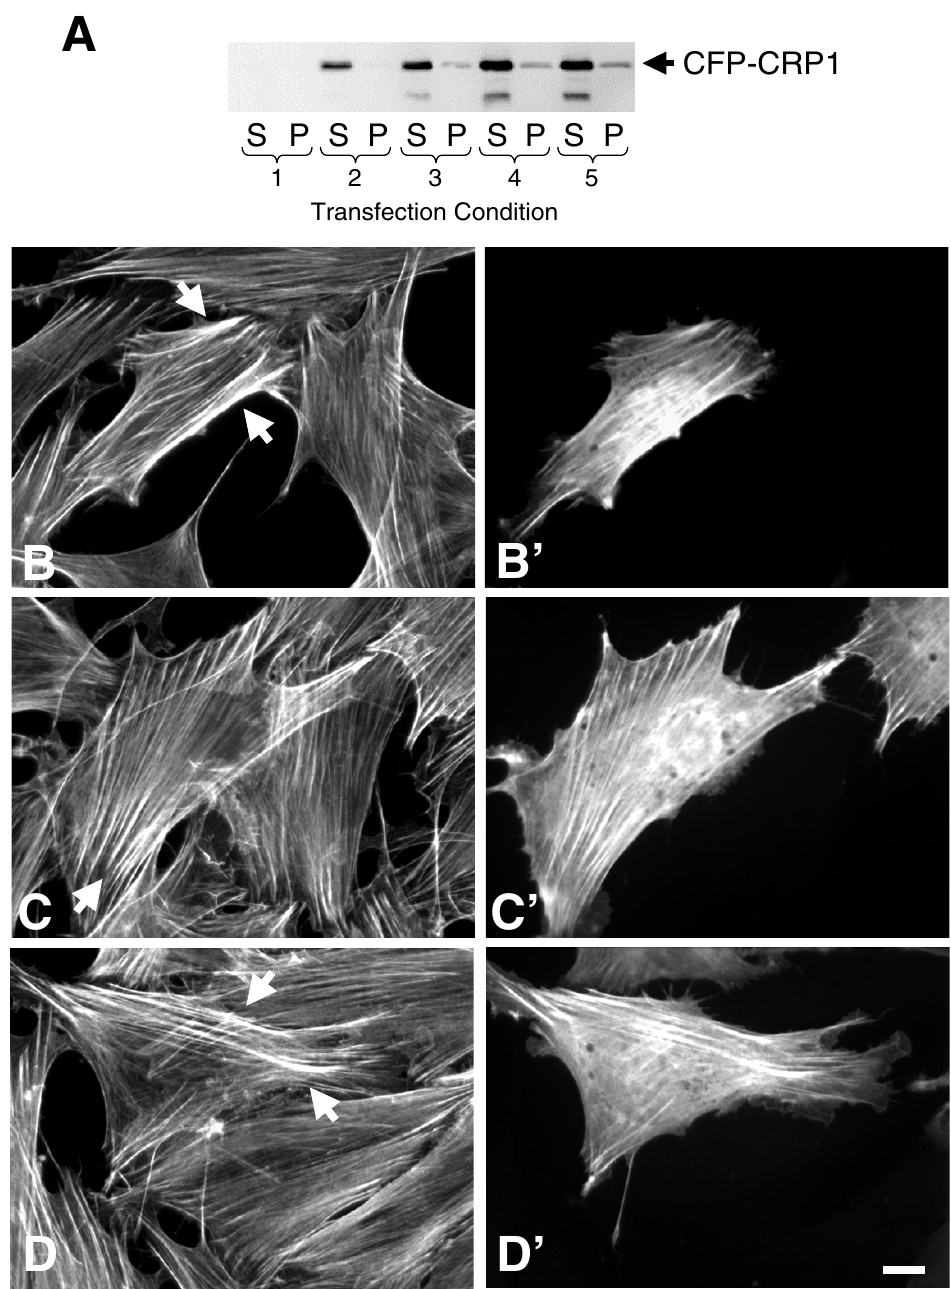
Figure 1 Expression of CRP1 increases the bundling of cellular actin filaments . REFs transfected with pECFP-CRP1 as described in Experimental Procedures were lysed and the Triton X-100 soluble and insoluble fractions separated for analysis. The transfection conditions were: 1) 6 µ L FuGENE, no DNA; 2) 3 µ L FuGENE, 0.5 µ g DNA; 3) 3 µ L FuGENE, 1.0 µ g DNA; 4) 6 µ L FuGENE, 1.0 µ g DNA; and 5) 6 µ L FuGENE, 2.0 µ g DNA. Immunoblot shows the expression of CFP-CRP1 in each fraction ( A ). REFs transfected with pECFP-CRP1 using transfection condition 4 were fixed and prepared for fluorescence microscopy. Rhodamine-phalloidin staining of F-actin ( A, B, C ) shows that the cells expressing CFP-CRP1 ( A', B', C' ) have enlarged stress fibers (see arrows). Results are representative of 4 separate experiments. Bar = 10 µ